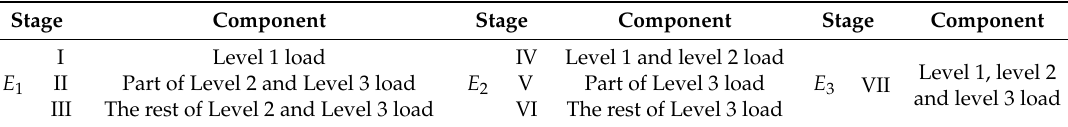
Table 5. Component of each stage of energy shortage.